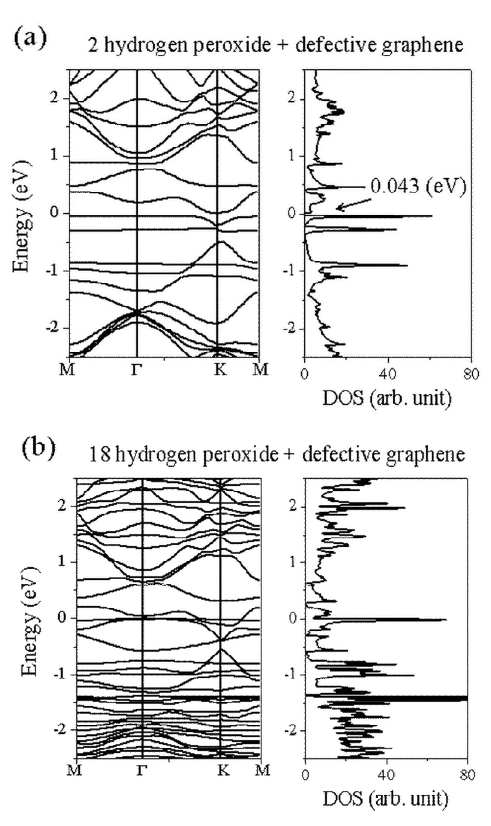
Fig. 7. Electronic band structures and DOSs of defective graphene in the presence of (a) two and (b) eighteen hydrogen peroxide per